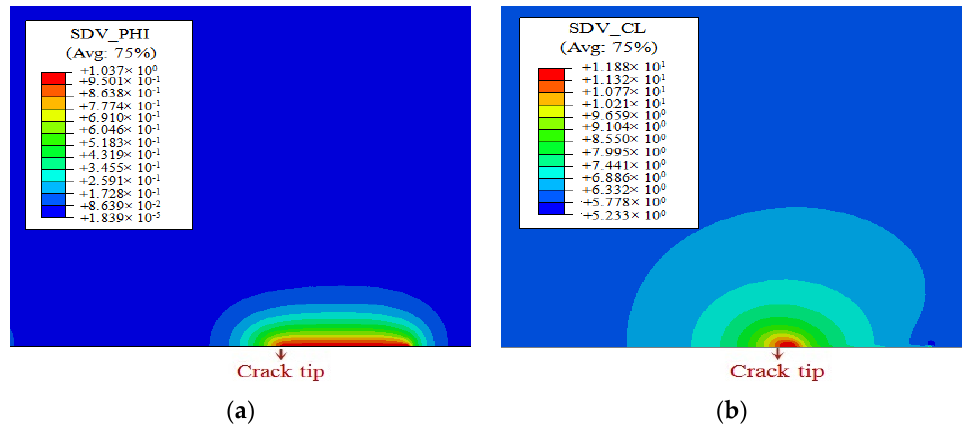
Figure 11. ( a ) Distributions of crack phase-field value and ( b ) hydrogen concentration at crack tip after some amount of crack propagation for C 0 = 7.0 ppm.